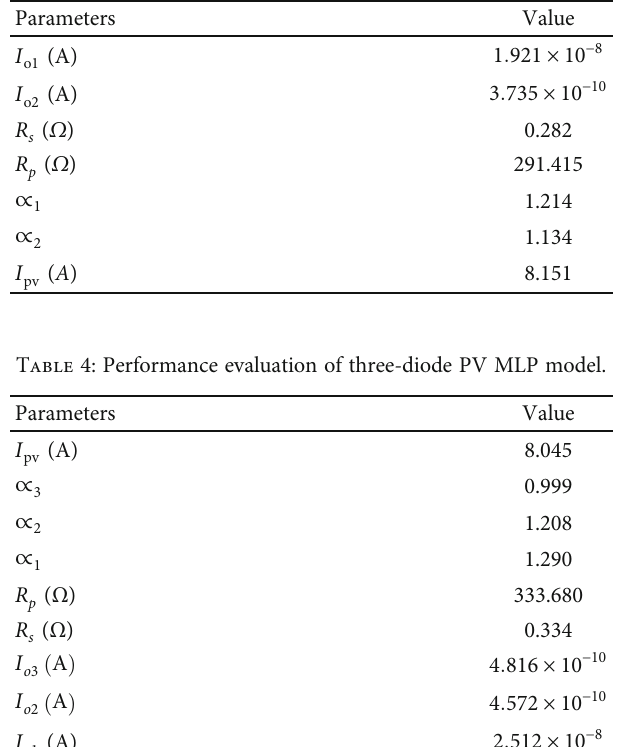
Table 3: Performance evaluation of double-diode PV MLP model. Parameters